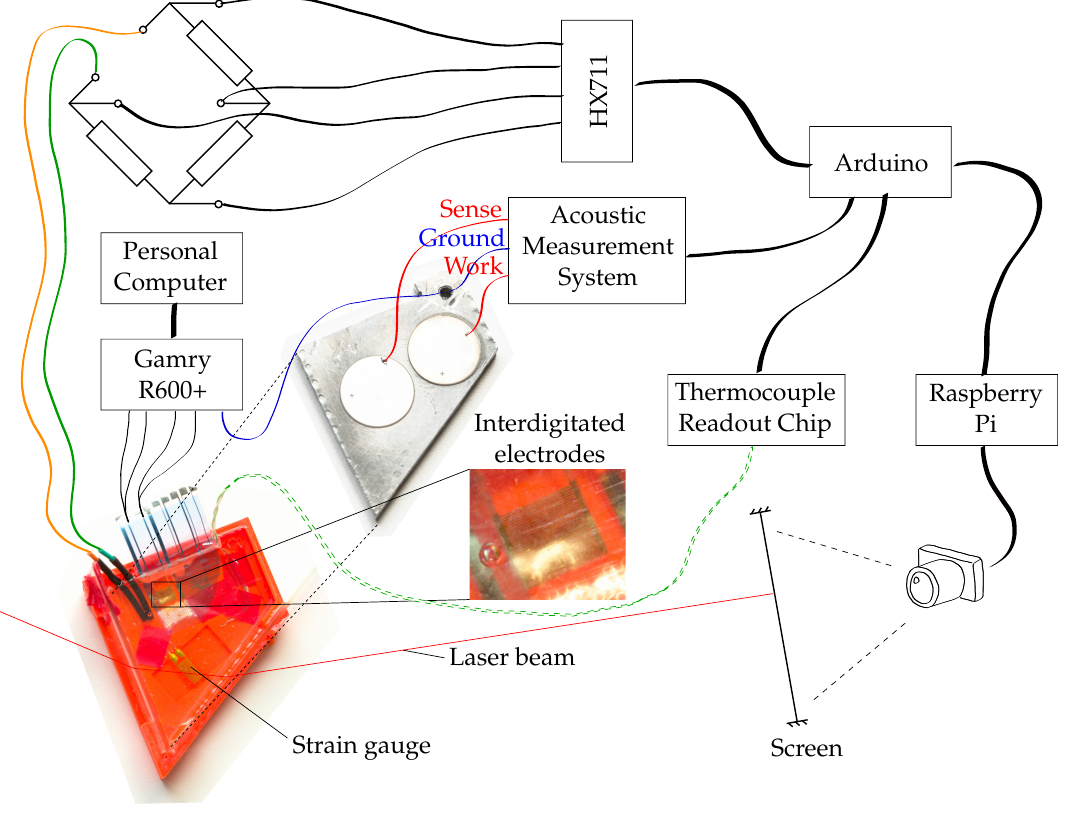
Figure 1. Measurement setup for the experiments described in this article. In the first experiment, the ground wire between the Gamry R600+ potentiostat and the aluminium plate was not